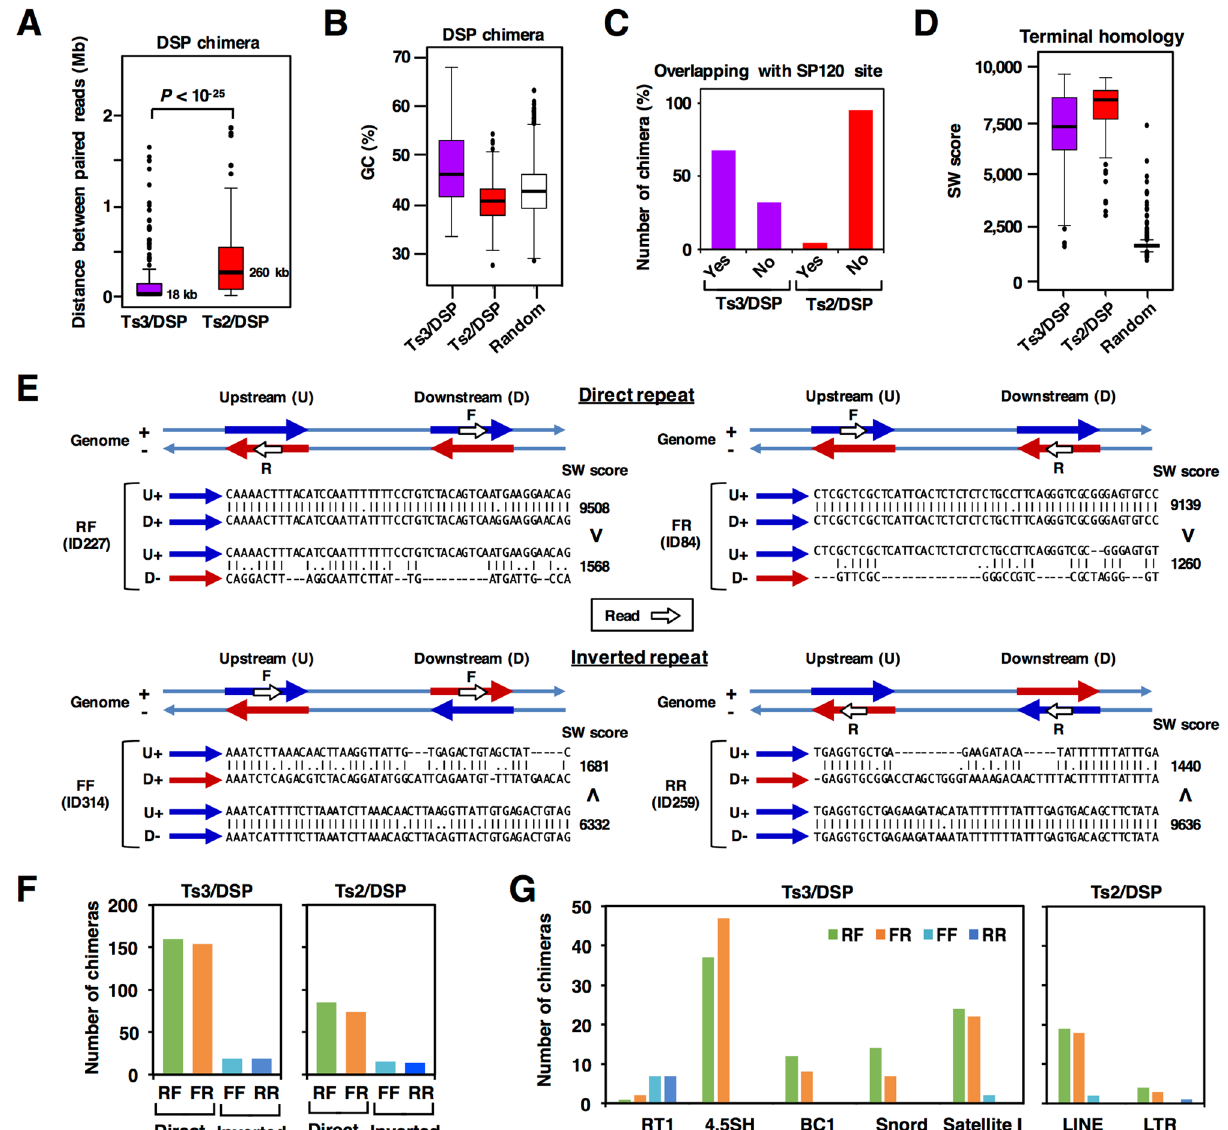
Figure 4. Analysis of DSP chimeras. ( A ) Length distribution of DSP chimeras. Horizontal bars indicate median length. ( B ) GC content distribution of DSP chimeras. As a control chimera, pairing was made between randomly selected 2 kb-segments from Chr 1 that are located within 2 Mb and their gap coverages were less than 20%. ( C ) Coincidence of DSP sites with SP120-binding sites as determined by ChIP-seq. ( D ) Distribution of the SW score for DSP chimeras, which indicates the sequence similarity between the chimera ends. Random pairing was made as in ‘B’. ( E ) Comparison of the combination between read orientations and sequence homology at chimera ends. To exemplify the relationships leading to a general rule, four Ts3/DSPs with different read orientations (RF, FR, FF, RR) were chosen arbitrary from Supplementary Table S5 (specified by their ID in the figure). Two kilobases of genomic segments that contain sequence reads in the center were subjected to homology search by EMBOSS Water program. Homologous segments are referred to as direct or inverted ‘repeat’ depending on their orientation. Pairwise alignments between upstream and downstream segments were done in two ways: plus-strand vs. plus-strand or plus-strand vs. minus-strand (U + vs. D + or U + vs. D-). Aligned sequences in the figure are 50-base region adjacent to the upstream reads. Resulting homology scores (SW score) and inequality signs are indicated on the right. ( F ) Differential abundance of DSP chimeras with direct repeats and inverted repeats at the homologous ends. ( G ) Matching of DSP chimera ends with annotated loci and RepeatMasker entries. RT1 stands for the rat major histocompatibility complex (MHC) genes. 4.5SH, BC1, and Snord are noncoding RNA genes. Satellite I locus resides mostly in pericentromeric regions. Browser view of these regions are presented in Supplementary Fig. S4 and Supplementary Fig.